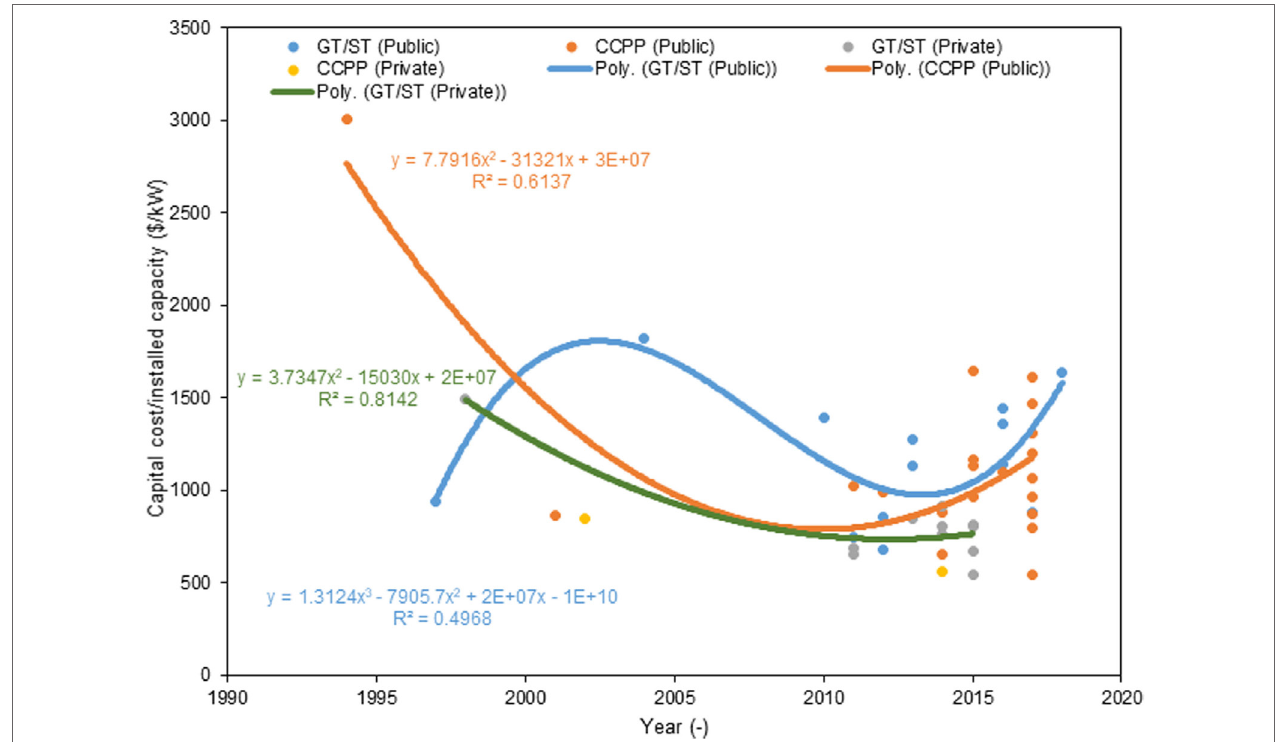
FigUre 5 | Cost evolution of different power generation technologies. In the case of coal, one subcritical power plants and two future ultra-supercritical ones not sufficient to see the cost evolution. For hydroelectric, solar PV, and nuclear, the power plant numbers are insufficient for analysis of learning rate or cost evolution. Under these circumstances, highly utilized technologies such as gas turbine engine and combined-cycle power plant (CCPP) for public and private power plants were analyzed for cost evolution.